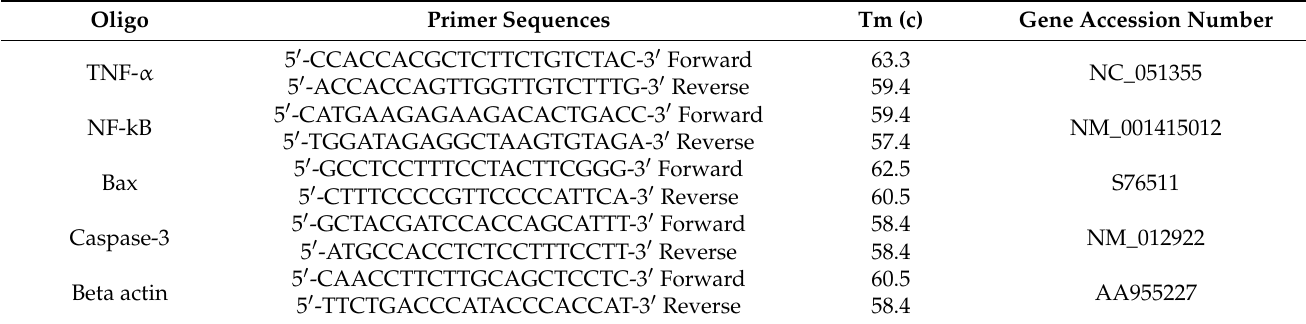
Table 1. qRT-PCR